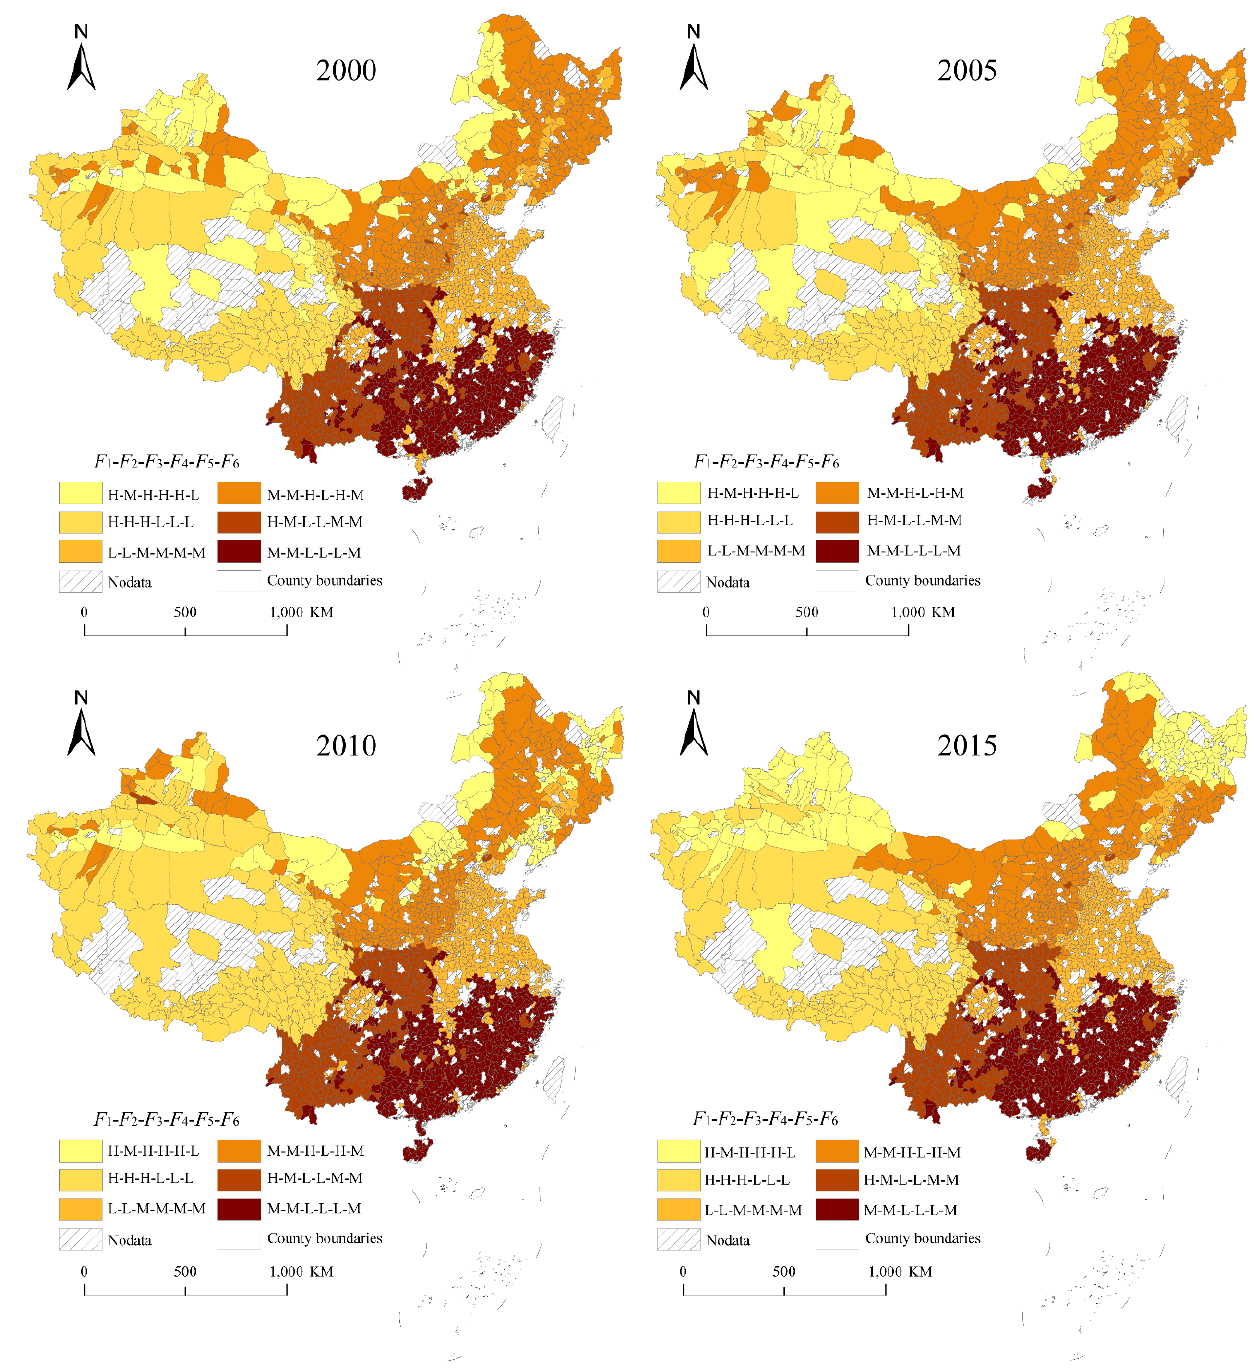
Figure 10. Categorized deprivation groups based on SOFM across China from 2000 to 2015: H is the high value interval of each PDF, L is the low value interval of each PDF, and M is the medium interval of each PDF.